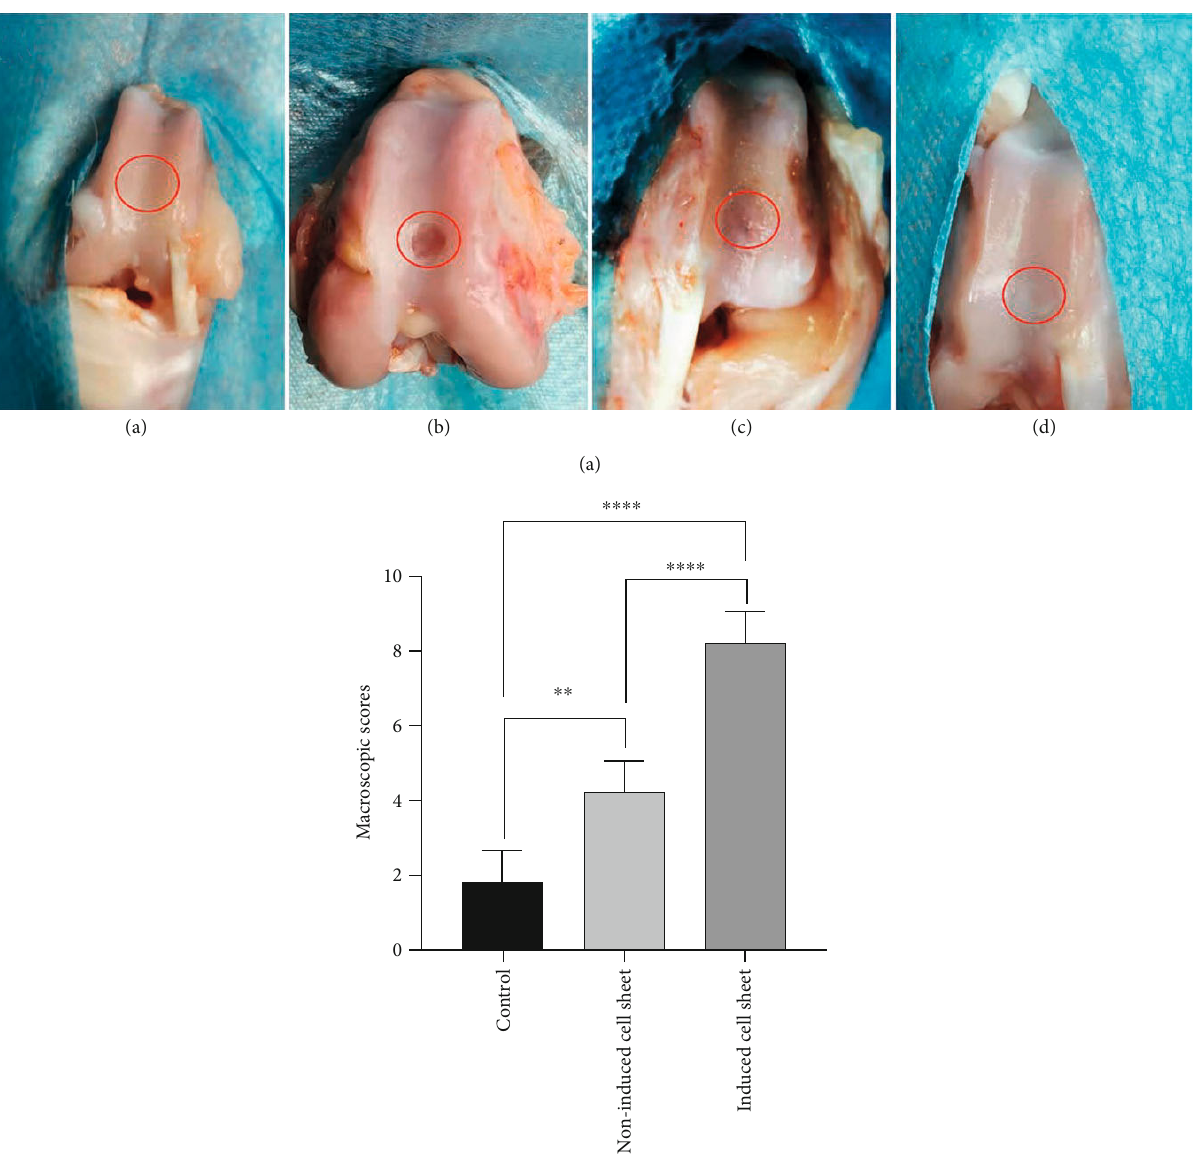
Figure 6: (a) Macroscopic observations of regenerative cartilage at 12 weeks after surgery. (A) Normal articular cartilage. (B) Control group. (C) Noninduced cell sheet group. (D) Chondrogenically induced cell sheet group. (b) International Cartilage Repair Society macroscopic scores of all groups at 12 weeks after surgery. ∗∗ P < : 01 ; ∗∗∗∗ P < : 0001